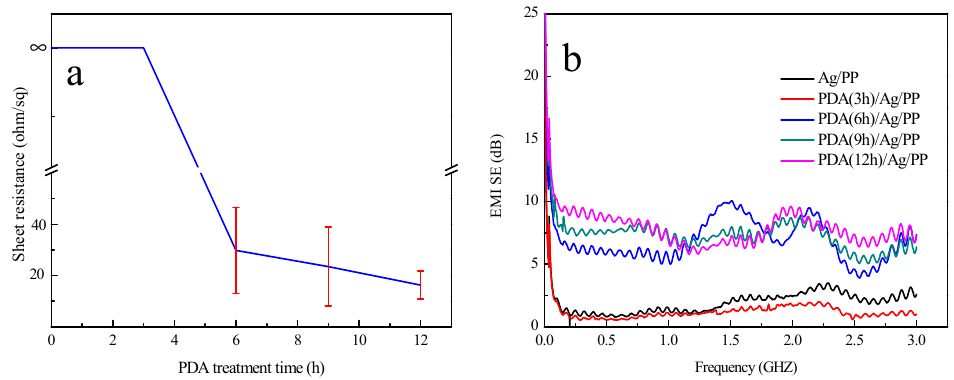
Figure 14. Electrical conductivity and EMI SE of the samples after washing: ( a ) sheet resistance of the treated samples and ( b ) EMI SE of the samples.